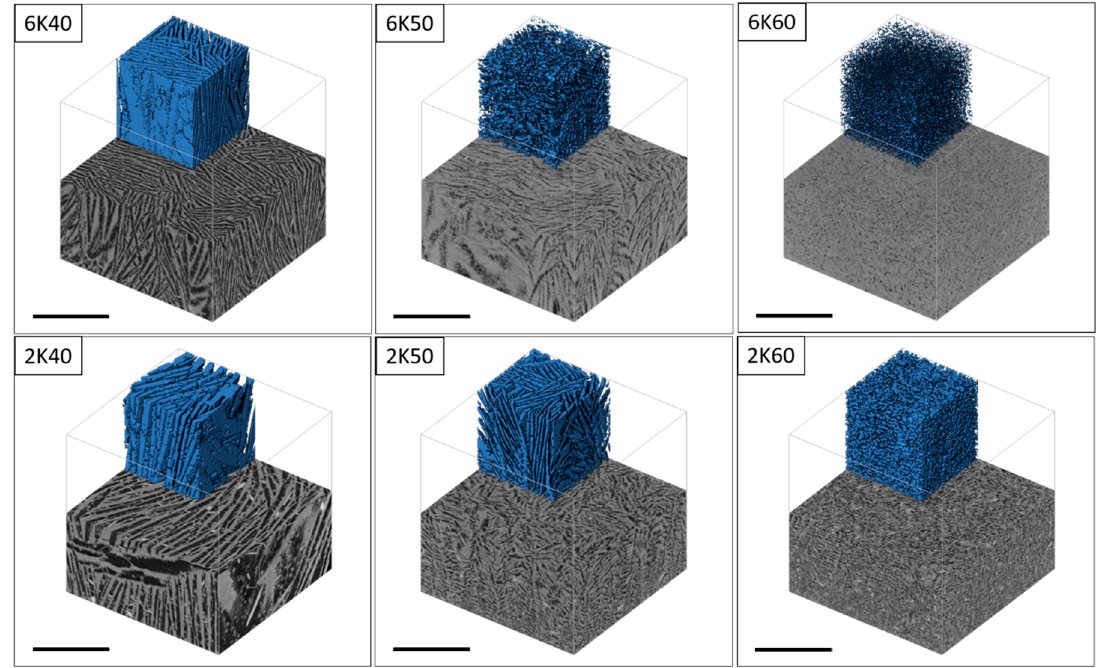
Figure 3. Influence of solid content on open porosity in specimens frozen at two different freezing rates.